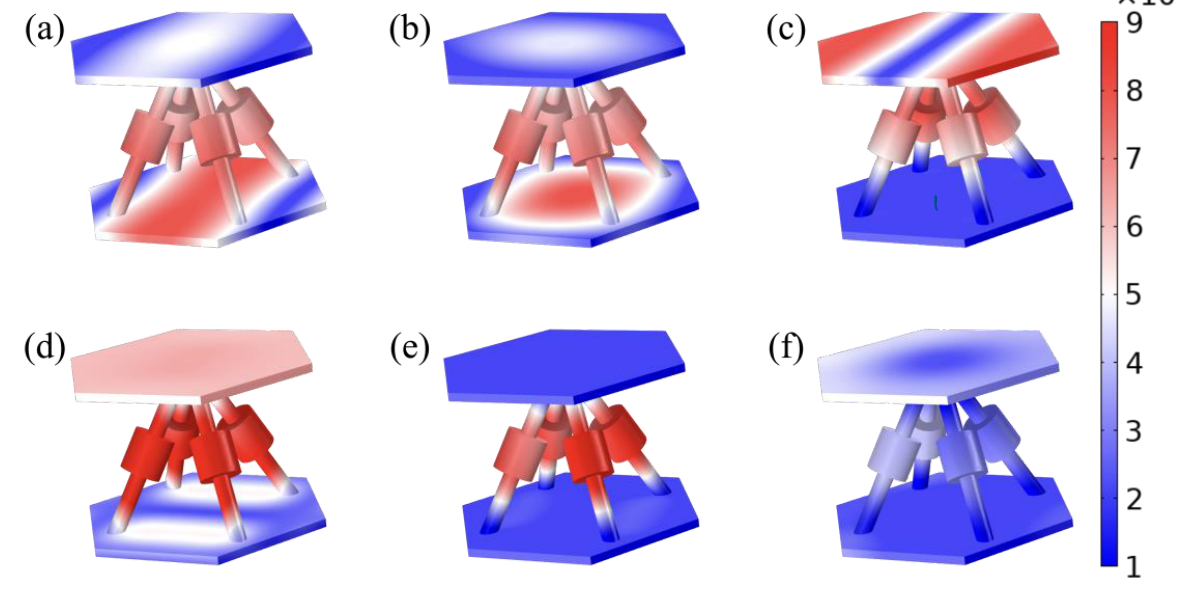
Figure 3. Eigenmodes of the SPLCRR unit cell at frequency ( a ) f A = 502 Hz ( b ) f B = 596 Hz ( c ) f C = 625 ( c ) f C = 625 Hz ( d ) f D = 874 Hz ( e ) f F = 964 Hz and ( f ) f E = 1003 Hz ( d ) f D = 874 Hz ( e ) f F = 964 Hz and ( f ) f E = 1003 Hz.